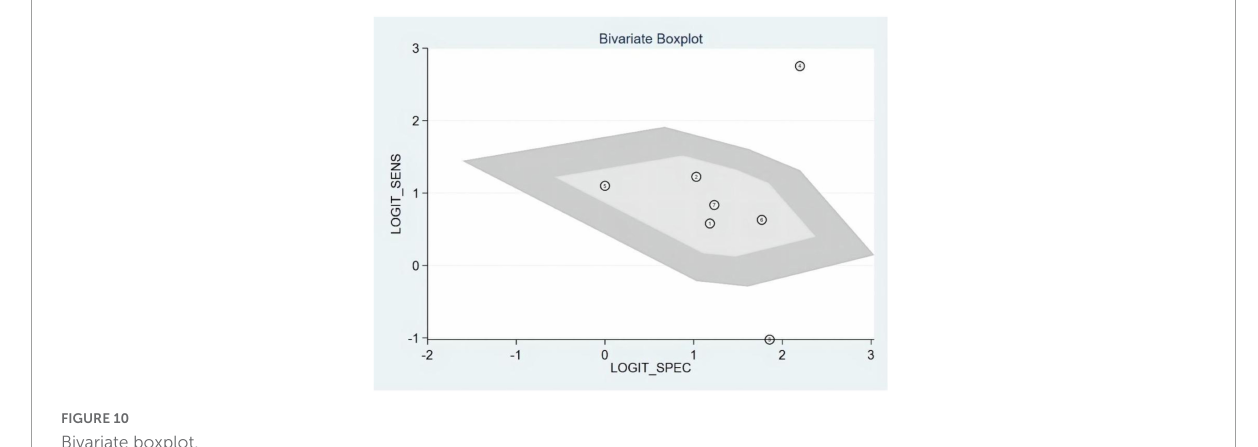
FIGURE10 Bivariate boxplot.